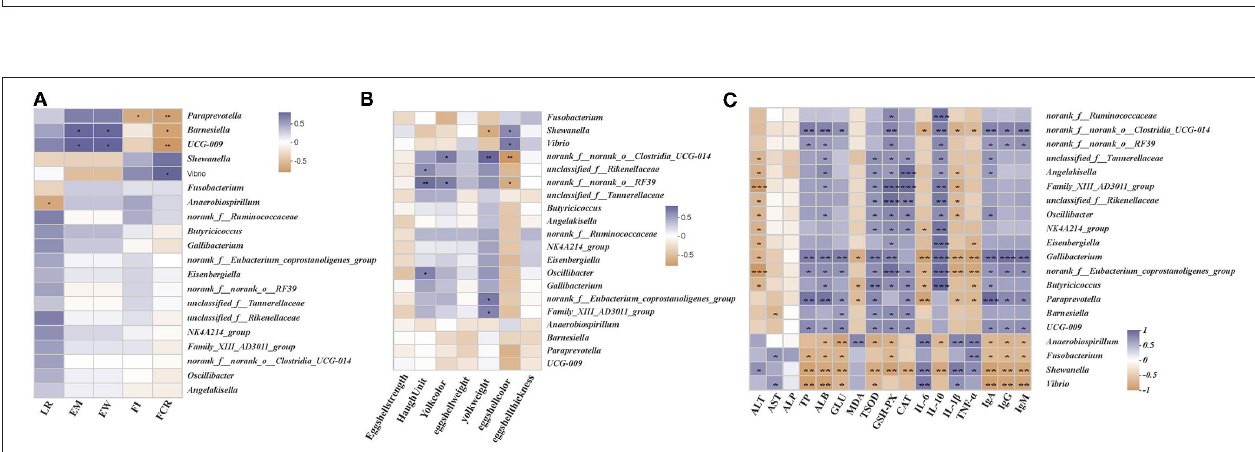
FIGURE 7 | Correlation between main parameters and differential microbes. (A) Relationship between the differential genera and performance. (B) Relationship between differential genera and egg quality parameters. (C) Relationship between differential genera and serum parameters. Asterisks denote significant differences (* p ≤ 0.05, ** p ≤ 0.01), n = 6 per